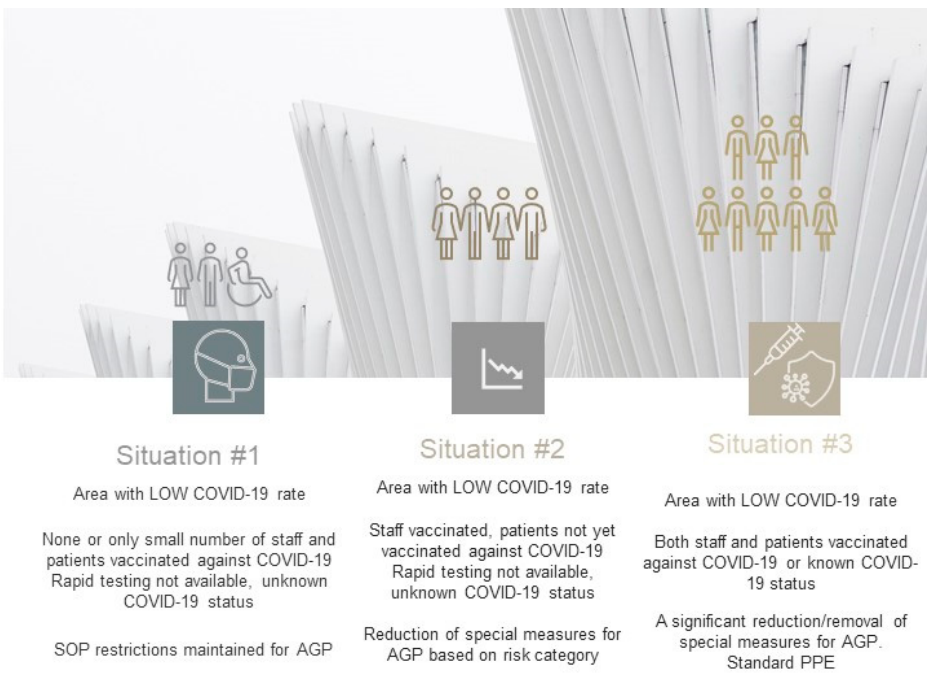
Figure 8. The proposal three-tier system in areas with low COVID-19 cases rate and testing not available. Options for change applicable for SOP depending on local COVID-19 cases rate and population immunity status. Stable, predictable COVID-19 rate locally.